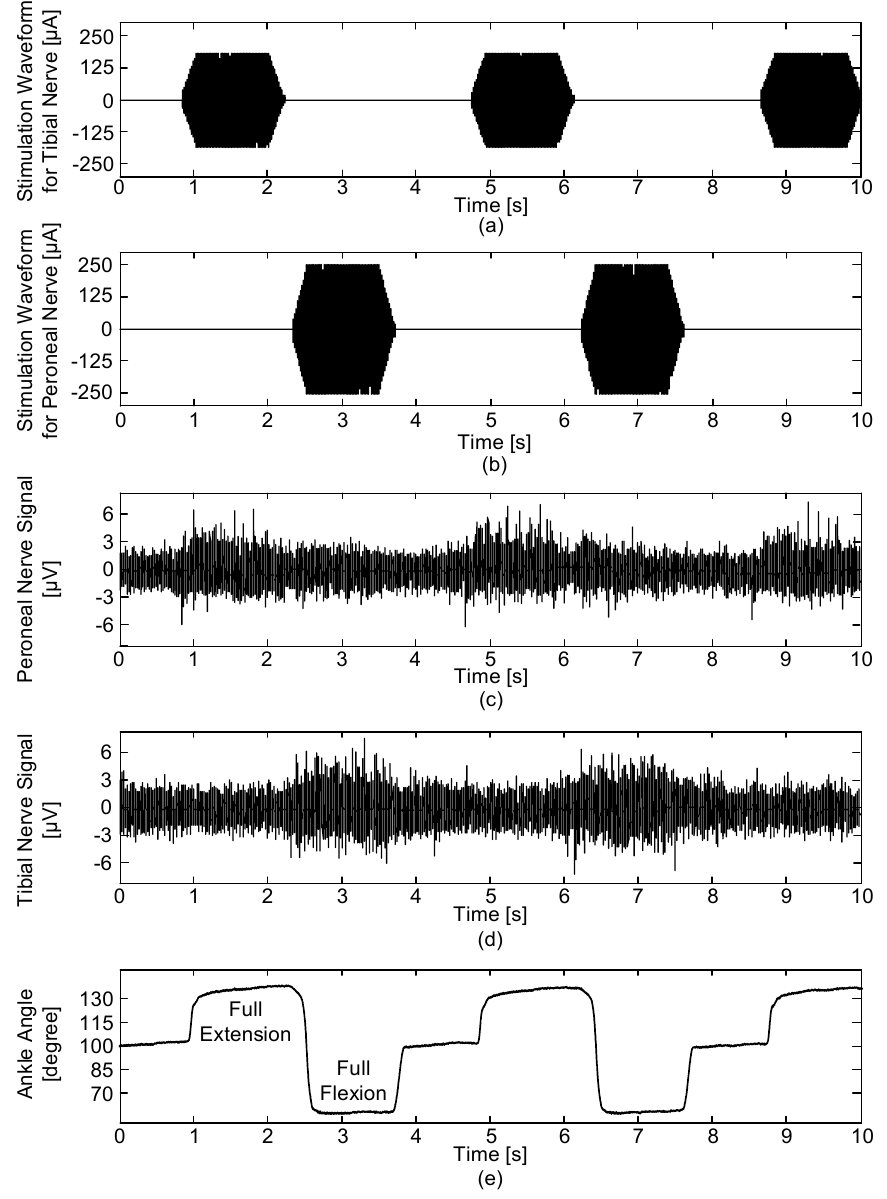
Figure 18. Acquired joint angle and ENG signals during the electrical stimulation period: ( a ) biphasic stimulation waveforms for the tibial nerve, ( b ) biphasic stimulation waveforms for the peroneal nerve, ( c ) ENG signals from the peroneal nerve, ( d ) ENG signals from the tibial nerve and ( e ) joint angle.